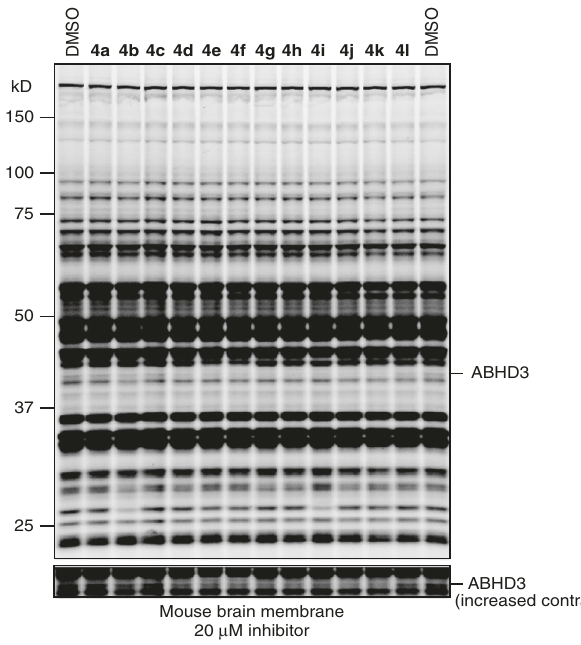
Fig. 4 MIDA boronates inhibit ABHD3 in mouse brain proteome. ABPP gel of the membrane fraction of mouse brain treated with compounds 4a – 4l (20 µ M, 30 min, 37 °C), followed by the broad-spectrum, serine hydrolase- directed activity-based probe FP-rhodamine (1 µ M, 30 min,